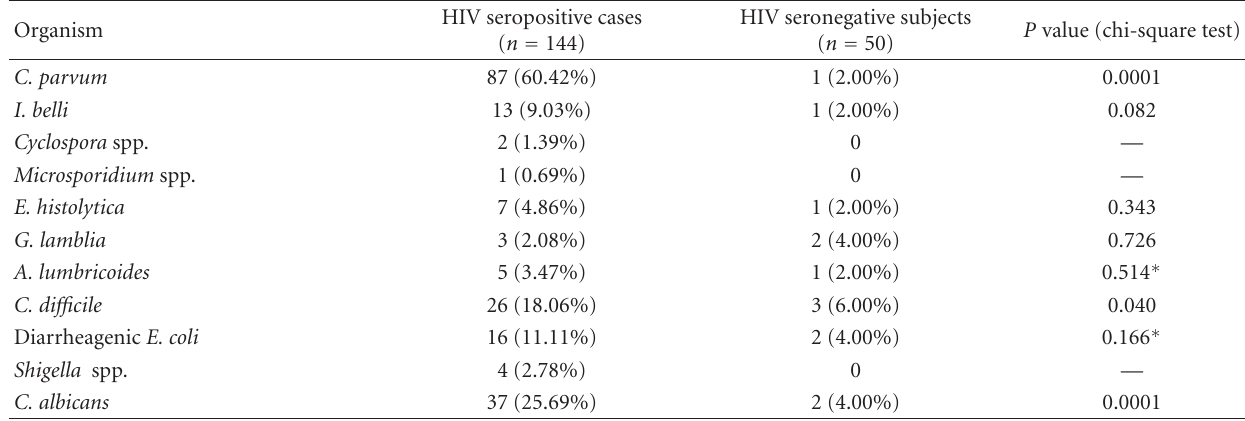
Table 4: Frequency of enteric pathogens in relation to the HIV status of study